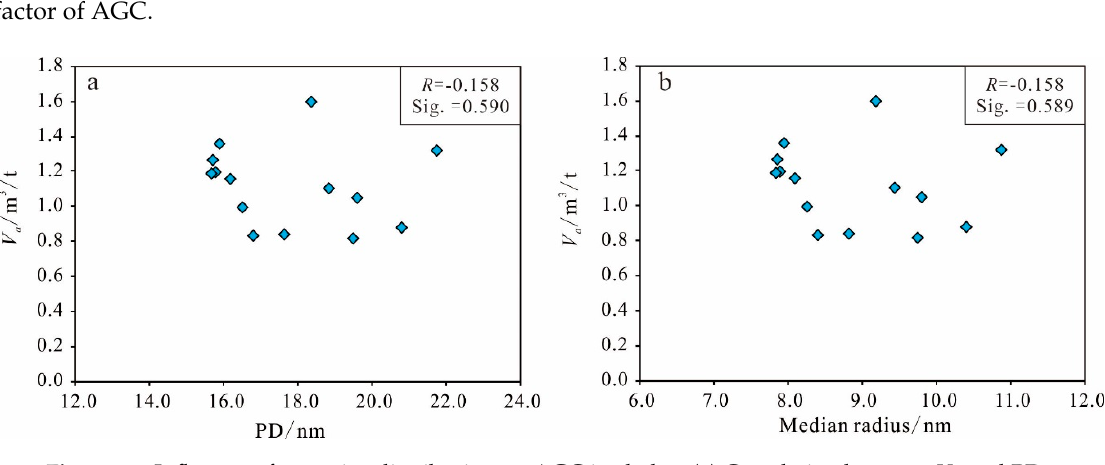
Figure 16. Influence of pore size distribution on AGC in shales. ( a ) Correlation between V a and PD; ( b ) correlation between V a and median radius.